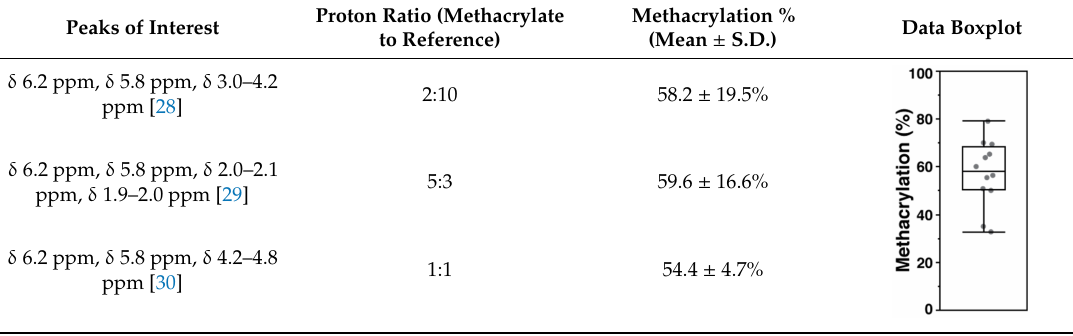
Table 1. Degree of methacrylation calculated using the three methods described in the literature. Calculated from 1 H-NMR spectra obtained from four di ff erent synthesis batches. Proton Ratio (Methacrylate Methacrylation % Peaks of Interest Data to Reference) (Mean ± S.D.)